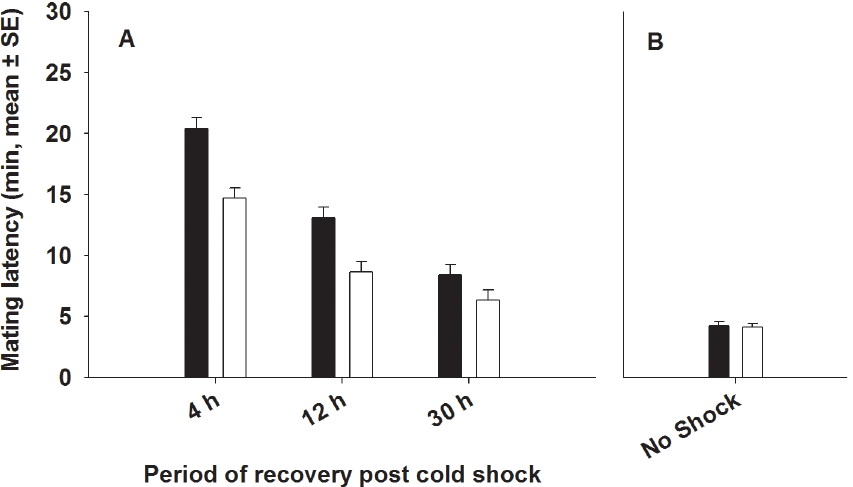
Fig 1. Effect of cold shock (A) or no shock (B) on mating latency. (A) We assayed mating latency at 4 hours (h), 12 h and 30 h post cold shock. Closed bars represent FCB and open bars represent FSB populations. Selection and period had significant effects on mating latency. However, selection × period interaction was not significant. (B) Under no-shock treatment, there was no significant difference in mating latency between FSB and FCB males.